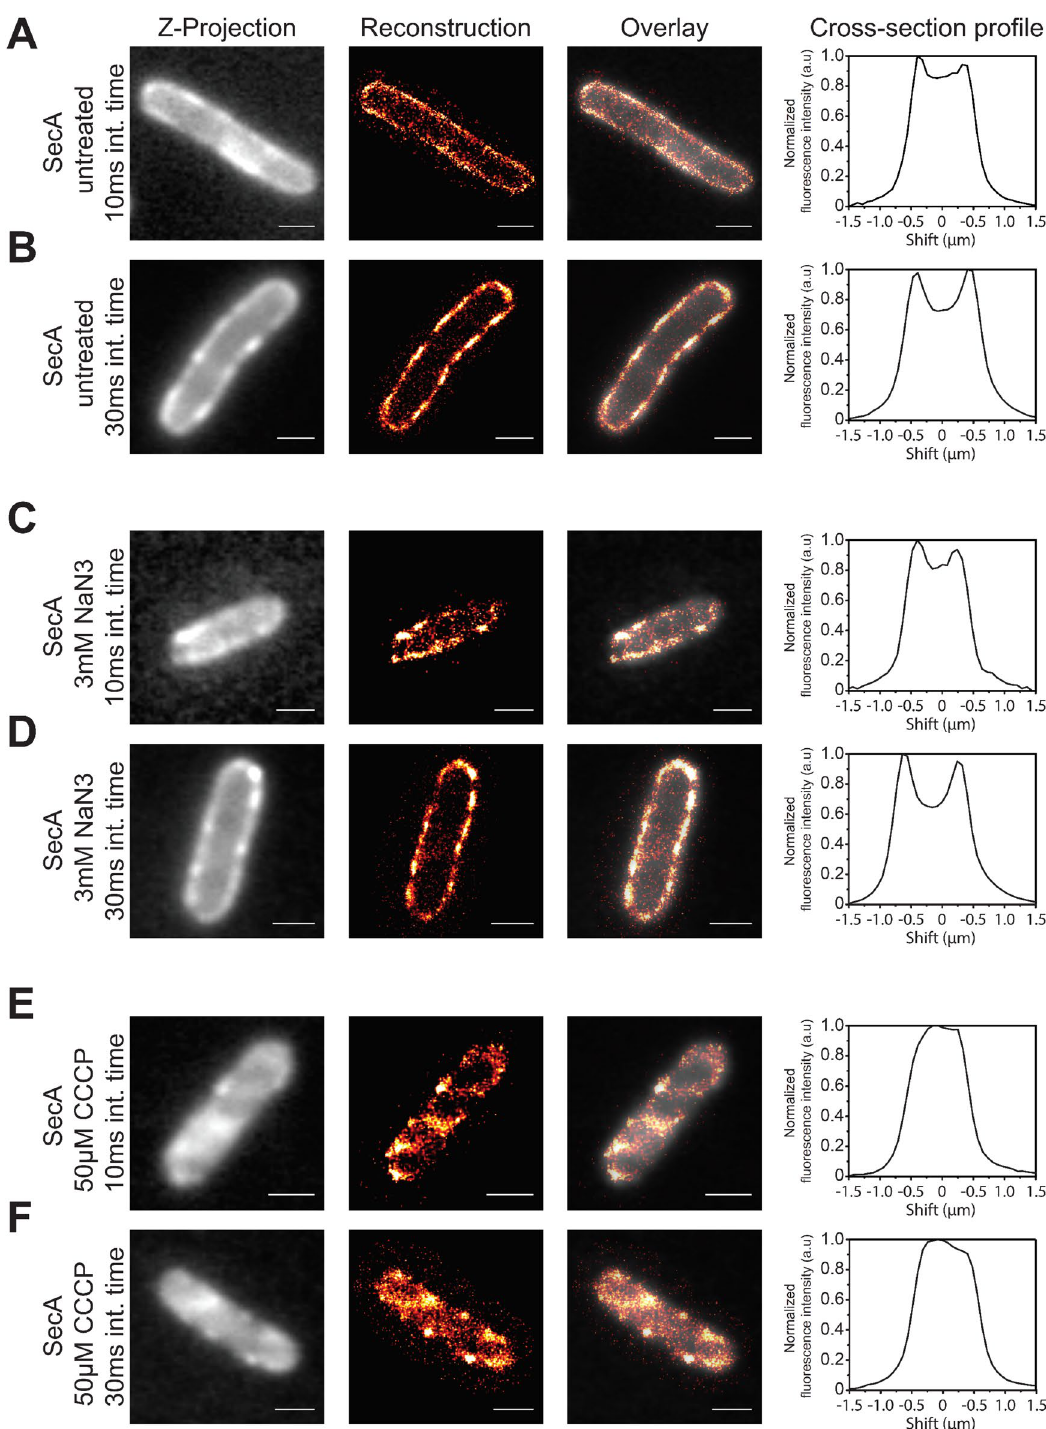
Figure 1. Super-resolution reconstructions and cellular distributions of SecA-Ypet under different conditions. ( A , B ) SecA under native conditions, ( C , D ) SecA-mediated translocation is blocked by 3 mM NaN 3 ( E , F ) protein translocation is impaired due to collapse of the PMF by 50 µM CCCP. ( A – F ). Visible in the left panels (Z-projection) are the results of averaging the fluorescence in the first 7.5 s into one image with a single frame acquisition time of 10 ms ( A , C , E ) and 30.5 ms ( B , D , F ). Signals observed in the cytosol are a combination of fast moving cytosolic (auto) fluorescence and out of focus signals originating from molecules within the cytoplasmic membrane on the axial axis. Second panel (Reconstruction), super-resolution reconstruction images showing signal detected at the cytoplasmic membrane. Colors indicate the frequency and accuracy of signal observed at the coordinate. Red indicating a low fit accuracy and/or frequency, whereas white signifies a high fit accuracy and/or frequency of fluorescence observed at that location. Third panel (Overlay), a merge of the super-resolution reconstruction with Z-projection to clarify the localization of SecA-Ypet. Fourth panel (Cross-section profile), a short axis cross section profile of the normalized fluorescence intensity distribution of each cell. Scale bar is 1